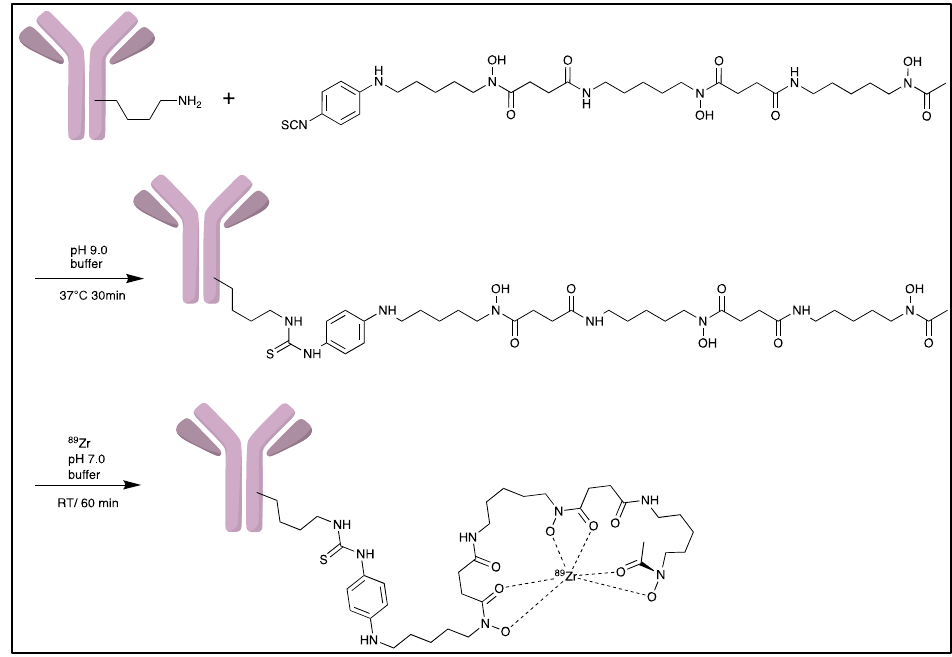
Figure 4. General procedure for p-NCS-Bz-DFO conjugation and 89 Zr radiolabelling with antibody.